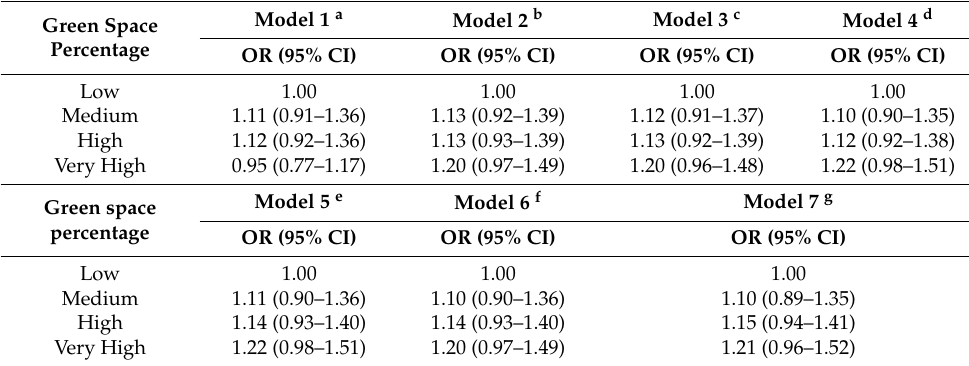
Table 2. Multilevel analyses for maternal exposure to green space during pregnancy and odds of antenatal depression for the entire cohort used to assess the effect of green space on antenatal depression from the Growing Up in New Zealand study